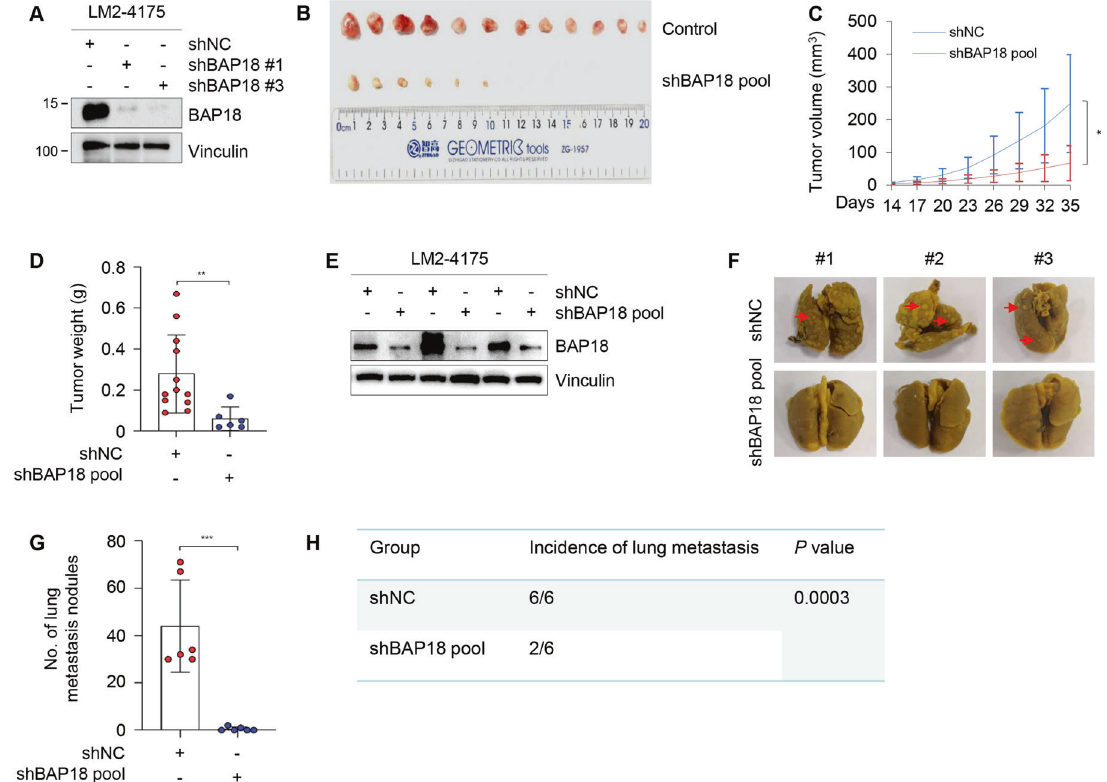
Fig. 4 Knockdown of BAP18 impairs xenograft tumor growth and lung metastasis of TNBC cells in vivo. A The ef fi ciency of BAP18 knockdown in LM2-4175 cells was veri fi ed by immunoblotting. B – D LM2-4175 cells (1 × 10 6 ) stably expressing shNC or shBAP18 pool (#1 and #3) were subcutaneously injected into mammary fat pads of 6-week-old female BALB/c nude mice ( n = 12). Five weeks after injection, xenograft tumors were removed from nude mice and photographed ( B ). The volume and weight of xenograft tumors are shown in C